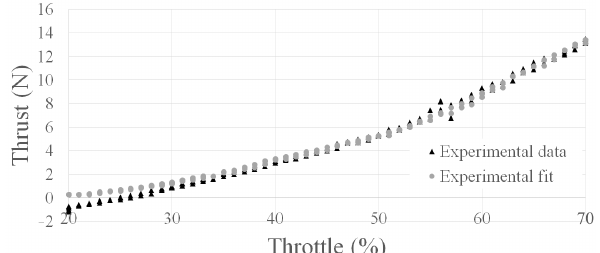
Figure 8. Experimental thrust curve fitting for 10 m s − 1 airspeed.